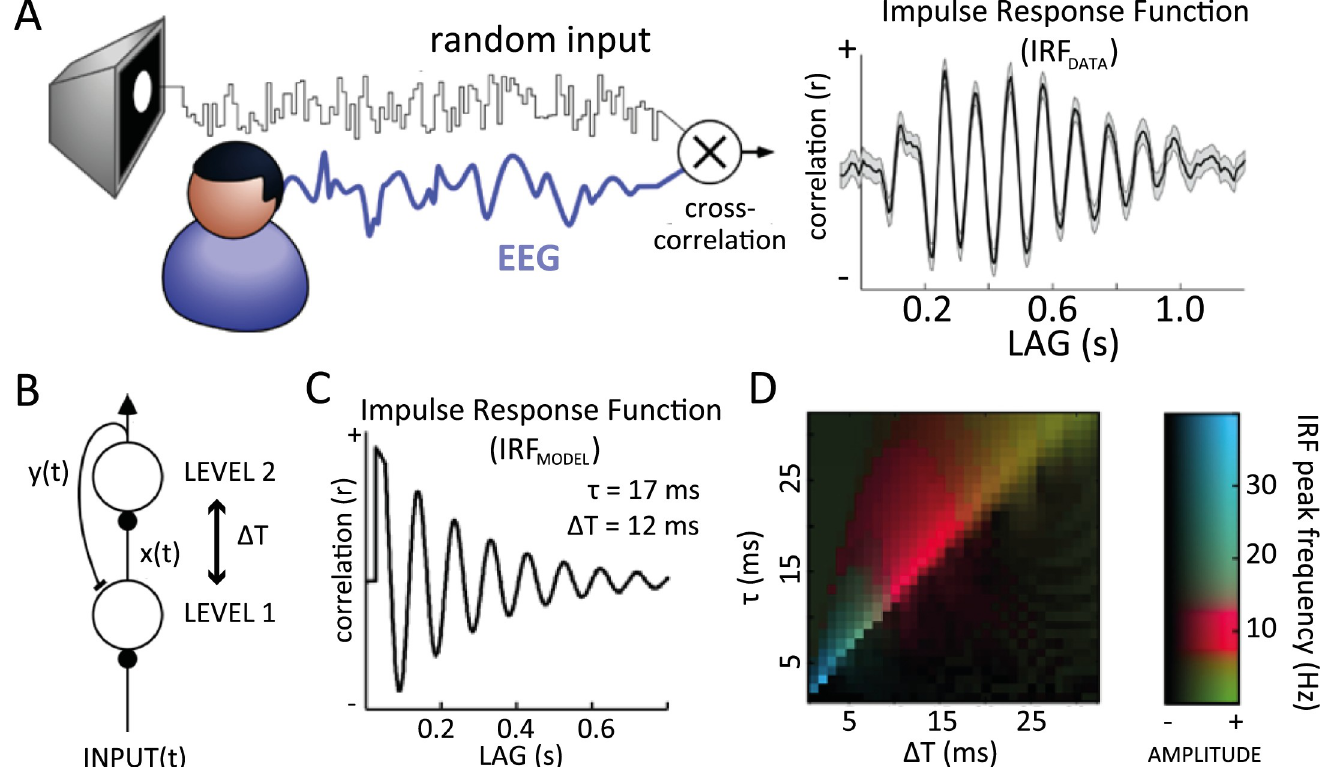
Fig 1. Alpha-band oscillations in human IRF and in a predictive coding model. (A) Cross-correlating the white-noise sequence of a stimulus with simultaneously recorded EEG produces an IRF, which reverberates at 10 Hz for several successive cycles (1 representative subject shown here, electrode POz). (B) A simple predictive coding model in which the hierarchically higher level makes predictions y(t) about the input received by the lower level, and the residual x(t) (prediction error) is used to update the next prediction. Residual and prediction signals are transmitted to the next or previous level (respectively) with a communication delay Δ T. Such a model, with physiologically plausible parameters, generates an oscillatory IRF at 10 Hz. (C) The oscillatory IRF produced by the model, with communication delay Δ T = 12 ms, and neural membrane time constant τ = 17 ms. (D) Systematic exploration of these two parameters suggests that alpha reverberation is a robust phenomenon (red colors) within a biologically plausible range of values. EEG, electroencephalography; IRF, impulse response function.